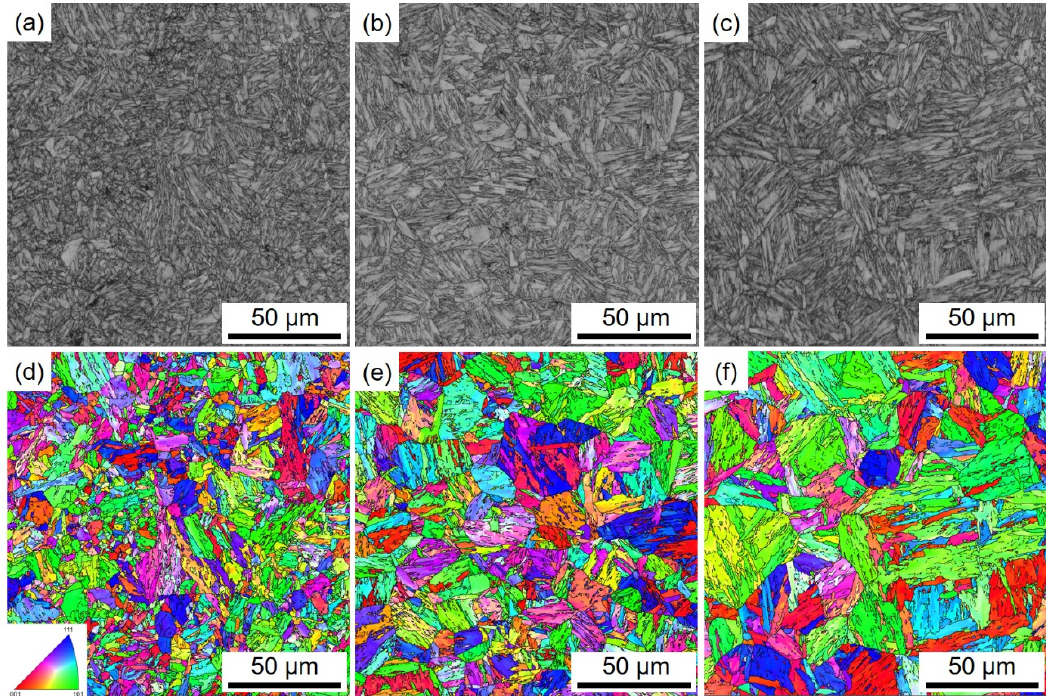
Figure 1. Band contrast map ( a – c ) and inverse pole figure color map ( d – f ) of three experimental samples: ( a ) and ( d ) Q850, ( b ) and ( e ) Q950, ( c ) and ( f ) Q1050.